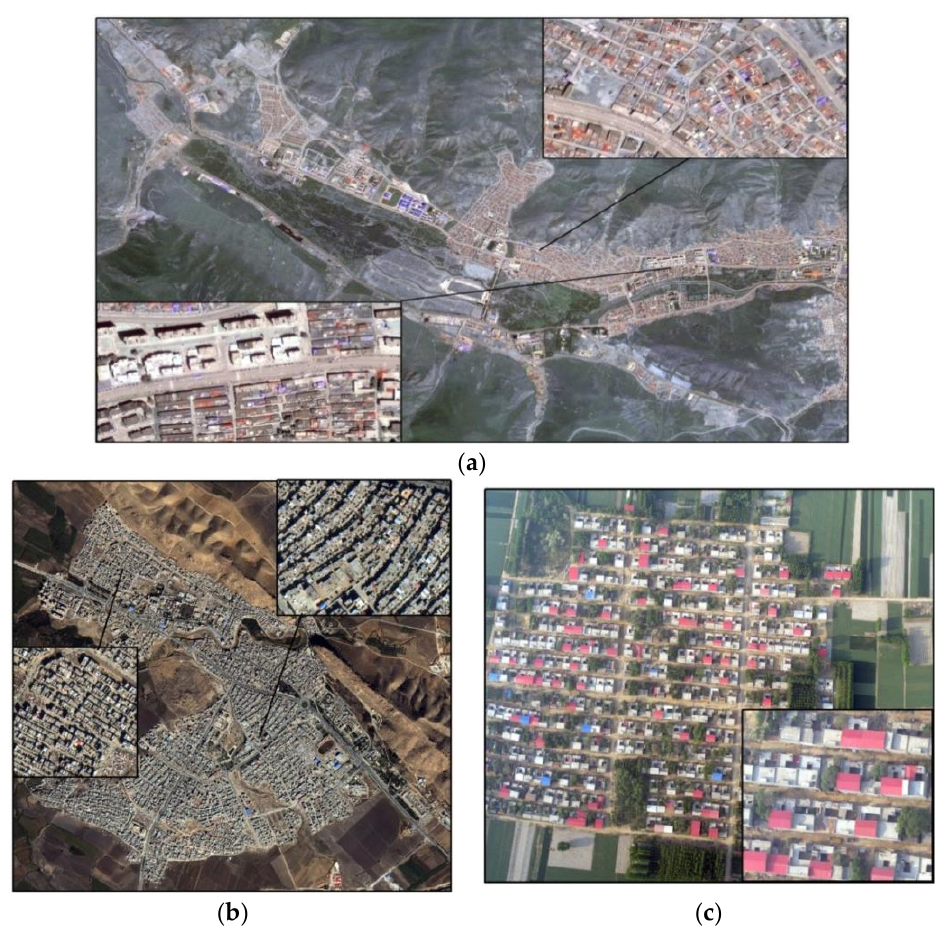
Figure 1. Experimental data (( a ) GF-2 satellite data, ( b ) BJ-2 satellite data, and ( c ) unmanned aerial vehicle (UAV) data).